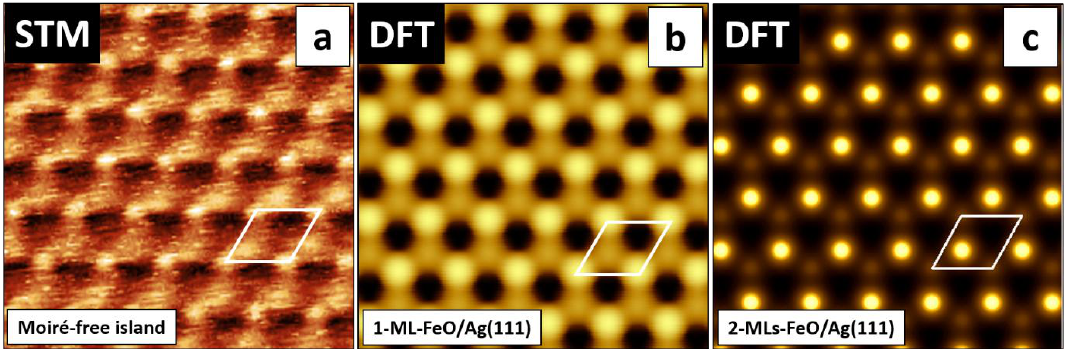
Figure 7. Atomic-resolution STM image (1.73 × 1.73 nm 2 , V = +0.1 V, I = 0.4 nA) obtained on the reconstruction-free island on the HT-FeO/Ag(111) sample ( a ). ( b ) and ( c ) present simulated images of a 1-ML-thick and 2-MLs-thick reconstruction-free FeO(111) films on Ag(111), respectively (see text for details). The simulation is based on density functional theory (DFT) calculations and the Tersoff-Hamann method [41]. The FeO(111)-(1 × 1) unit cell is marked with a white rhombus.